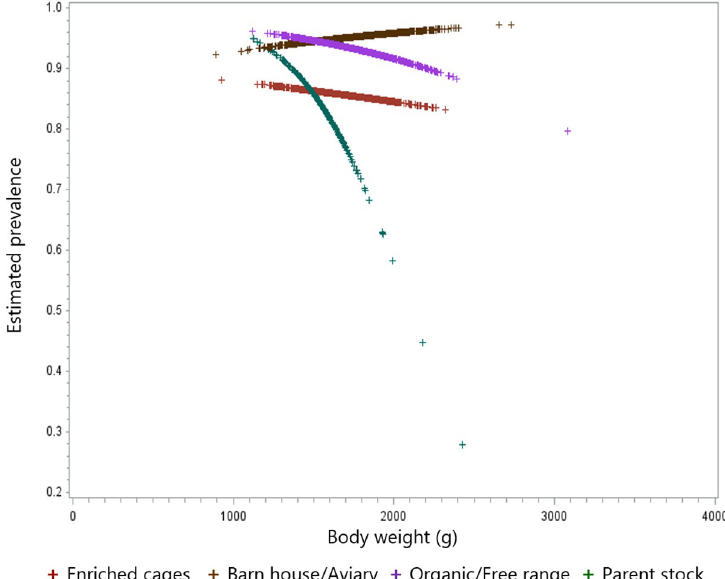
Fig 4. Scatter plot of the estimated prevalence of KBF for each hen as a function of the body weight at depopulation.